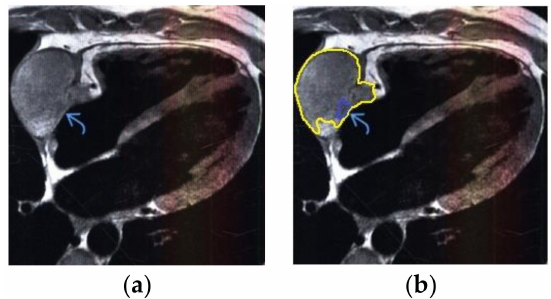
Figure 7. Heart MRI: ( a ) image with white noise and ( b ) denoised image with contrast enhancement of sarcoma in the right atrium.